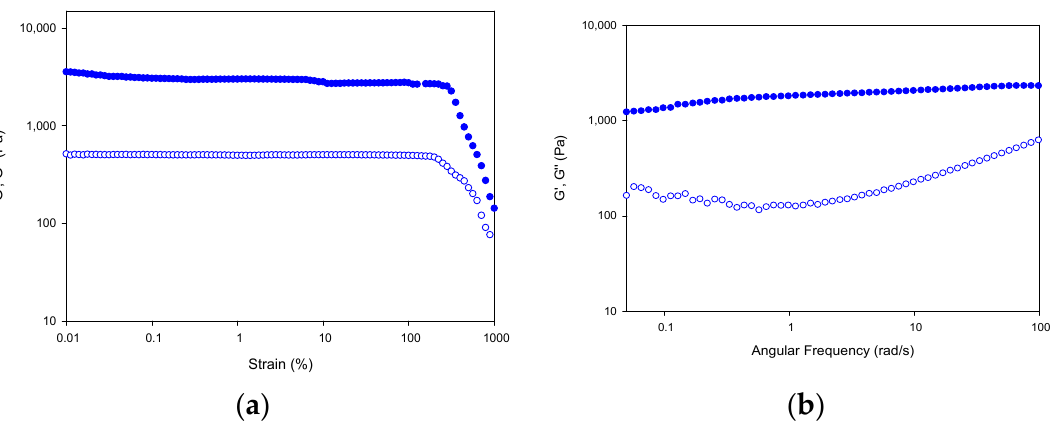
Figure 12. Strain and frequency sweep for Tuna gelatin hydrogel. Storage (G’; filled symbols) and loss moduli (G’’; hollow symbols) depicted versus strain ( a ) and angular frequency ( b ) at 20 °C. In addition, the resistance of the gel network at 20 ◦ C (at the sol/gel transition) can be assessed by studying the frequency dependence of the viscoelastic moduli (Figure 12b). The hydrogel network shows a gel-like behavior as indicated by the superior storage modulus over the loss modulus (G (cid:48) > G (cid:48)(cid:48) ) with a parallel like profile in the frequency range under study [59]. The high values for storage and loss modulus of the tuna gelatin hydrogel indicate the presence of a high concentration of its helical structures [5]. In addition, the tuna gelatin hydrogel features a highly complex viscosity (Figure 13), similar to previously discussed fish gelatins [23–25] that is typical of a strong gel matrix in agreement with the previous cryo-SEM analyses (Figure 7). Generally, the higher viscosity of gelatin at steady conditions permits it to maintain the integrity of the gel formulation whereas the change of viscosity produced at the sol/gel transition upon shearing makes it suitable for preparing complex structures with good shape printability upon cooling [5]. Furthermore, the gelation kinetics of the tuna gelatin hydrogel were determined by monitoring the complex, loss and storage moduli as well as the viscosity on heating in the critical gelation temperature range as revealed by MDSC (10–40 ◦ C) and its subsequent reversibility upon cooling (40–10 ◦ C, Figure 13). A sharp transition in complex viscosity occurs in the thermal interval between 18 ◦ C and 25 ◦ C (Figure 13a,b) as well as the storage and loss moduli (Figure 13c,d) during the heating ramp, which is indicative of the disruption of the hydrogel elastic network and in agreement with the sol/gel transition observed around for 25GE hydrogel by MDSC that is similar to previously reported in the literature for other fish gelatin [5,24,25].